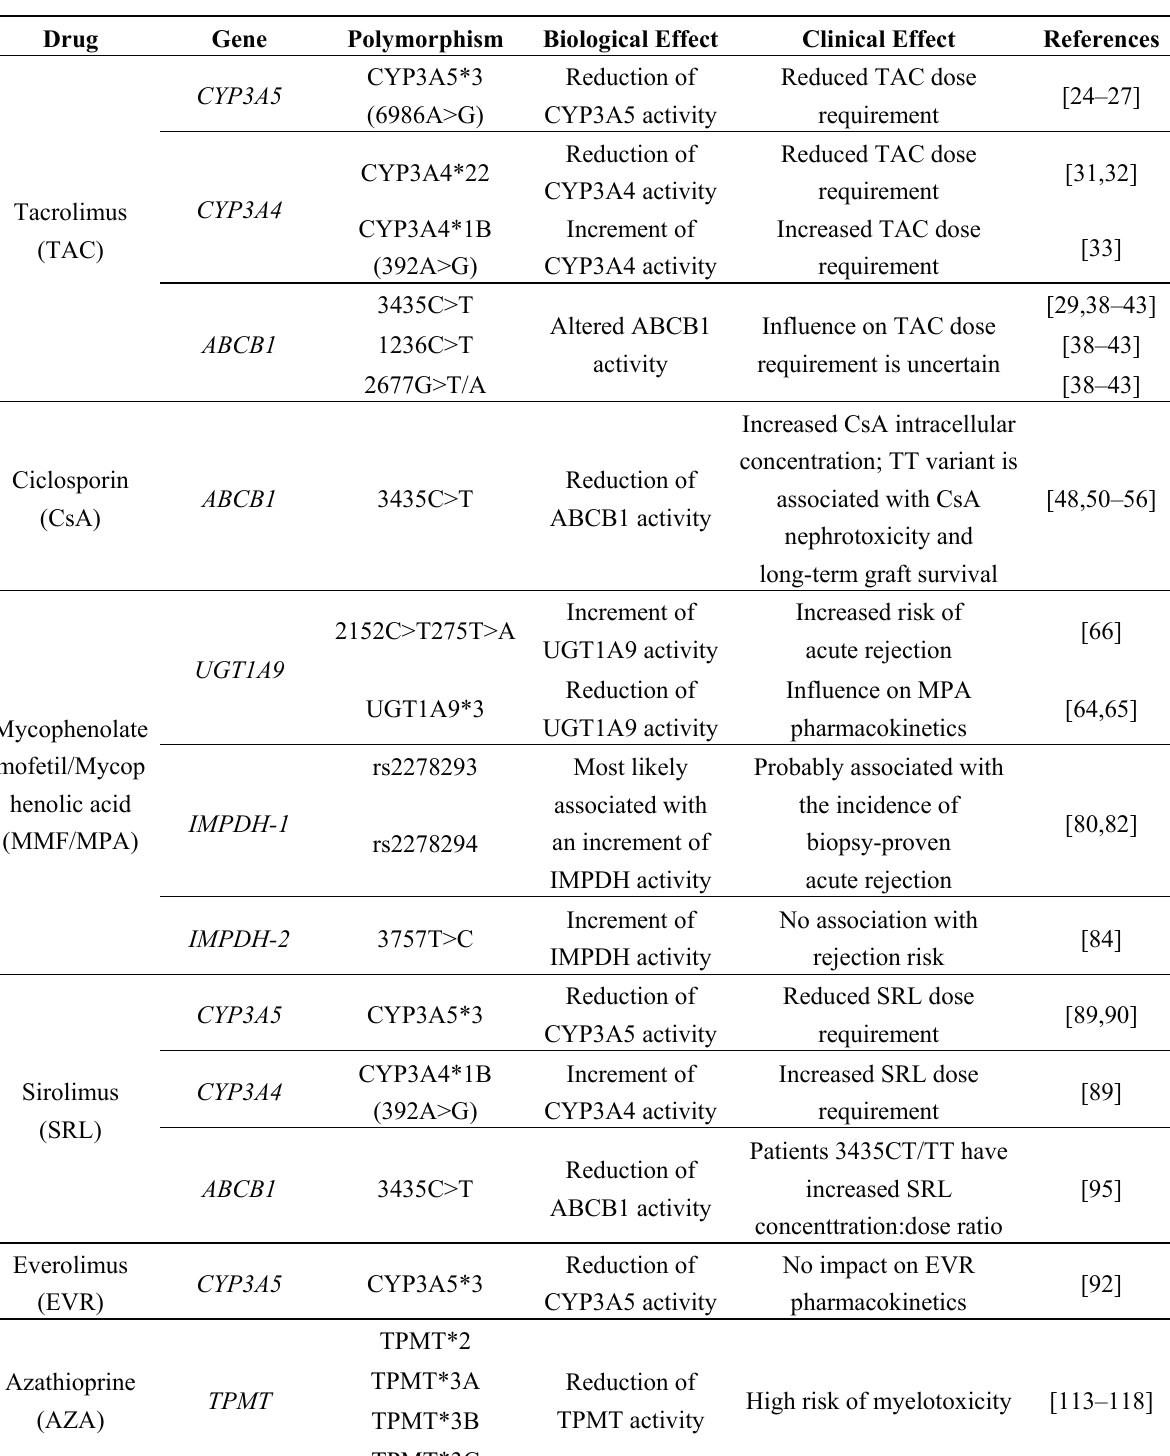
Table 1. Gene polymorphisms and their